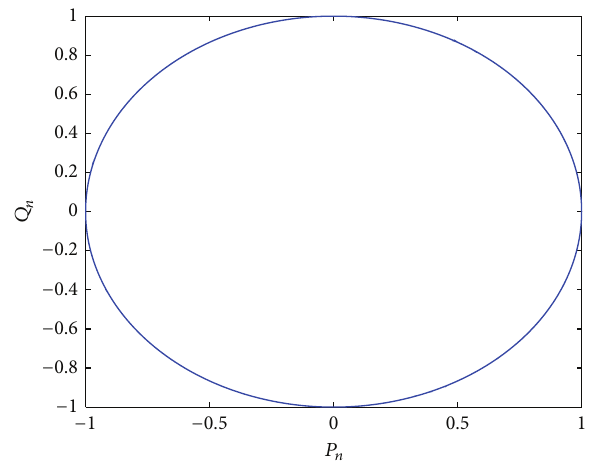
Figure2:Applying(18)tosimulate(16)withfixedstepsize ℎ = 0.02 .